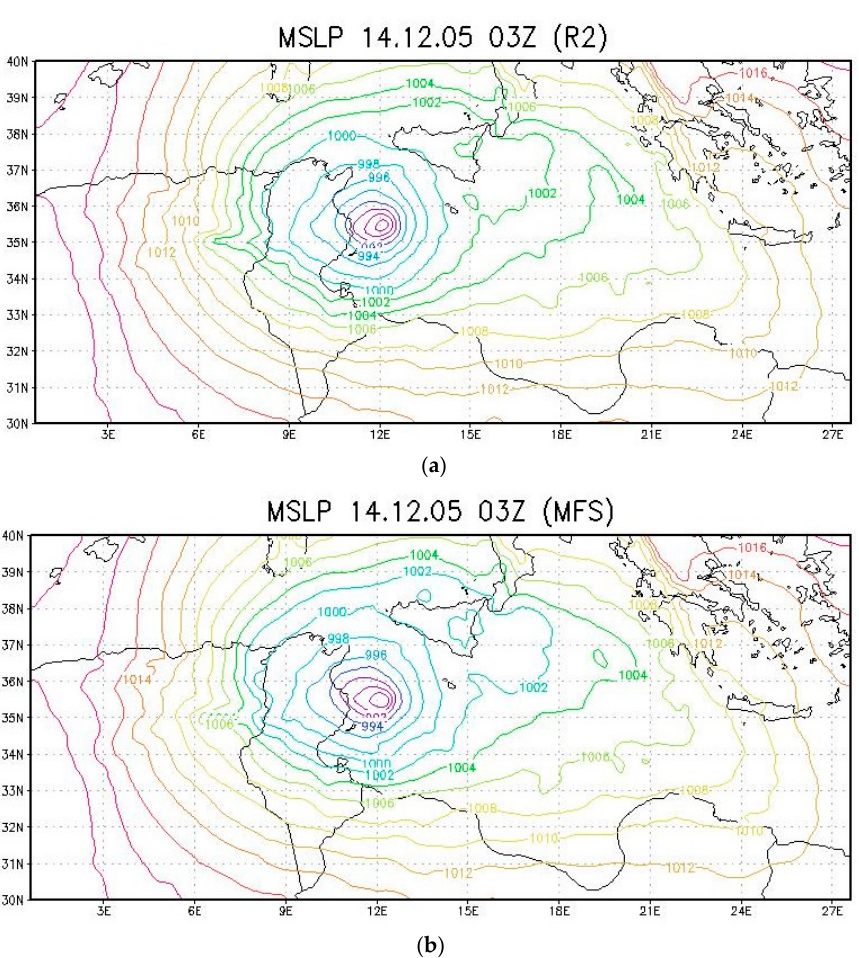
Figure 13. MSLP (hPa) on 14 December 2005 03UTC from ( a ) the R2 run and ( b ) the MFS run. The most intense rainfall occurred the day before the peak of the storm, between 06– 12 UTC 13 December 2005 as shown in the TRMM data in Figure 4. The corresponding model results (3 h accumulated rainfall expressed in units of mm h − 1 ) for both model runs are shown in Figure 14. The general pattern, location and maximum rainfall rates over Sicily are reproduced reasonably well by the model although the precipitation appears is narrower bands as compared to the TRMM data. This may be partially due to the higher resolution of the model (10 km) compared to the TRMM fields (25 km).